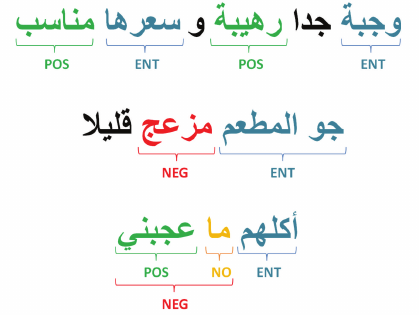
Figure3:Anexampledepictingapositivesentenceandtwonegative sentences. In each sentence the significant words and/or phrases are